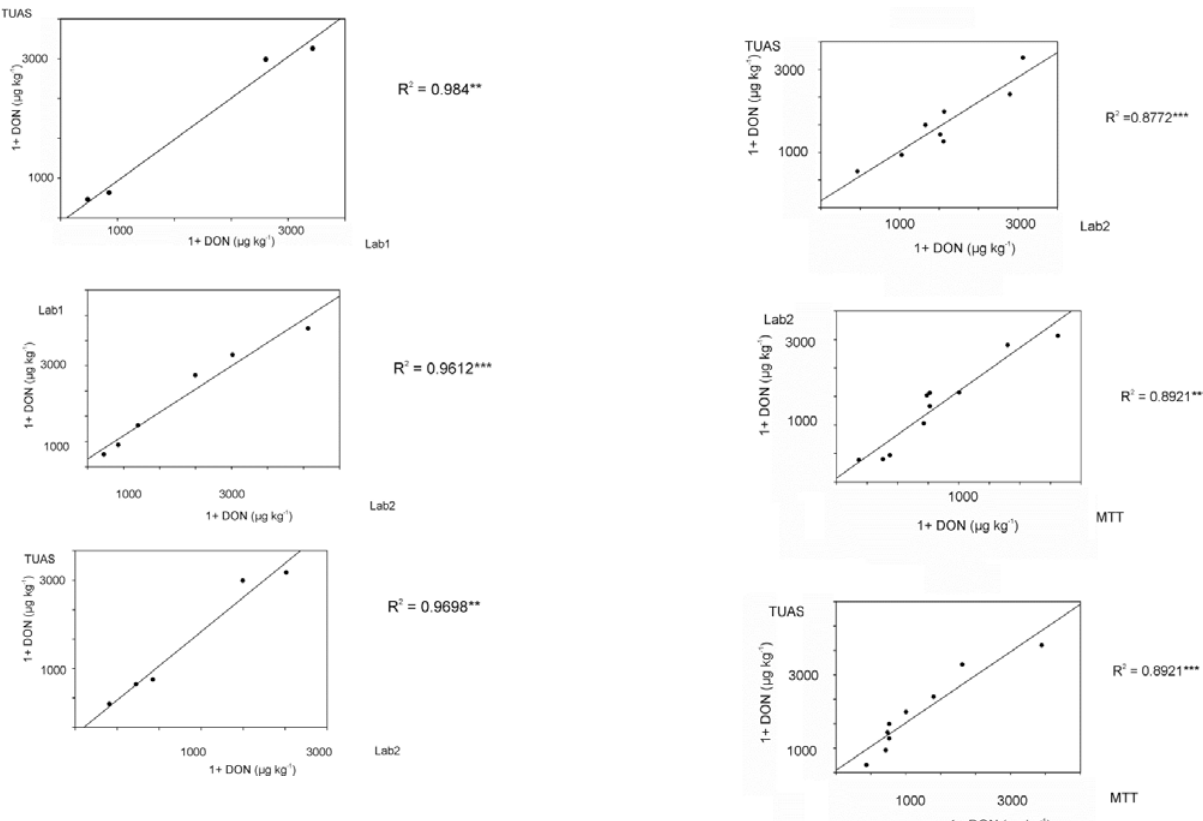
Figure 5. Correlations between log DON concentrations in wheat grain samples ground at Lab 2 (a) and MTT (b), both in mills with sieves. *** indicates statistically significant ( P <0.001 or